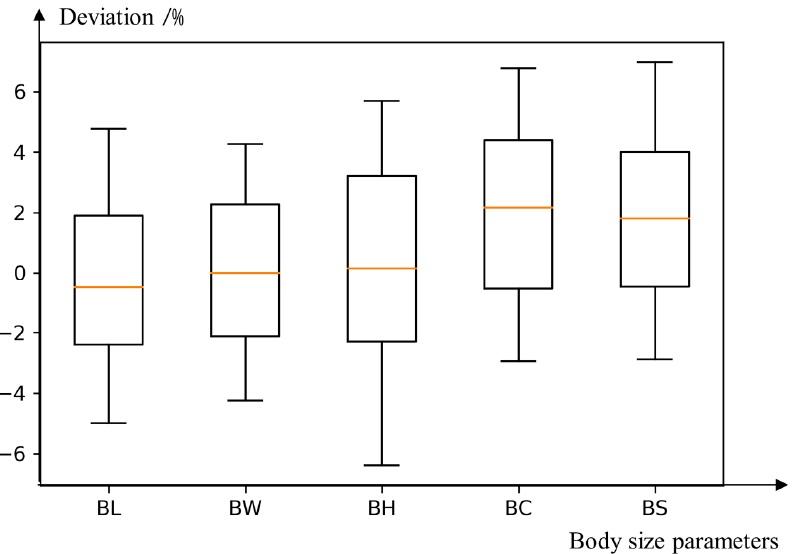
Figure 16. The error distribution of each body dimension (calculated for 182 sets of point clouds corresponding to 10 beef cattle).